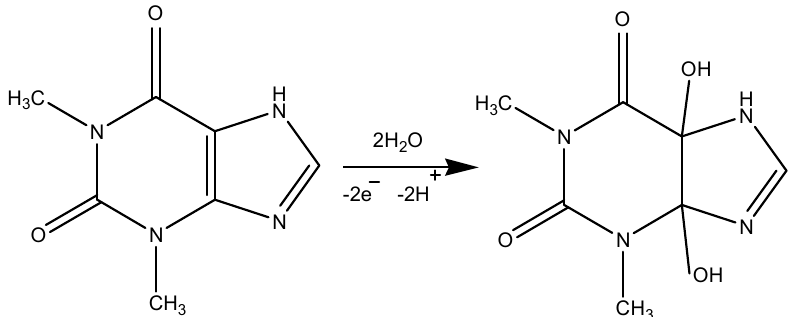
Figure 6. ( A ) Cyclic voltammograms of the THP (0.1 mM) in the PBS of pH 6.0 for the varying scan rates from 0.01 Vs −1 to 0.3 Vs −1 ; t acc =10 s. ( B ) Plot of I p (μA) on √ ט . ( C ) Plot of log I p vs. log υ. ( D ) Plot of E p vs. log υ.